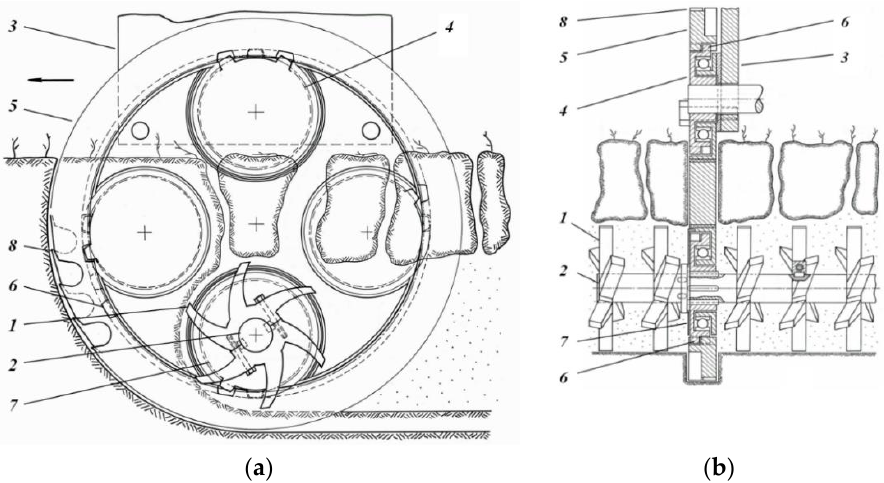
Figure 5. Intra-soil milling machine PMS – 280, ( a ) side view, ( b ) front view. Mills, 1; shaft, 2; frame, 3; driving gear, 4; ring cogwheel, 5; internal gearing, 6; driven gear, 7; external cutter,